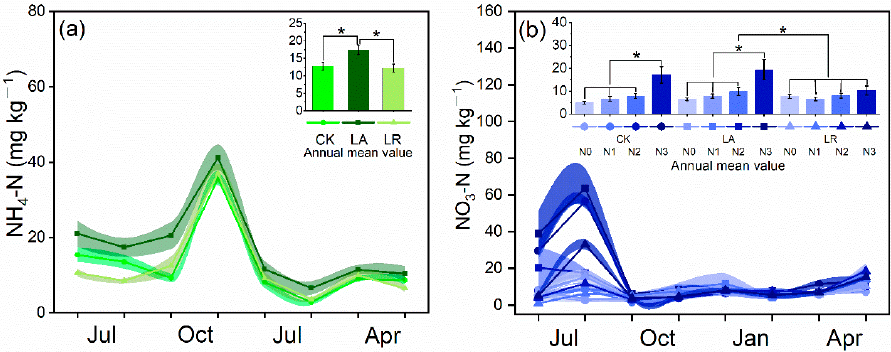
Figure 3. Seasonal variations and annual mean values of soil (NH 4 -N) ( a ) in di ff erent litter input treatments and (NO 3 -N) ( b ) in di ff erent N fertilizers and litter inputs treatments. Spline curves indicate mean ± SE ( n = 12 for NH 4 -N, n = 3 for NO 3 -N). Asterisks (*) indicate significant di ff erences (ANOVA followed by Duncan’s tests, p < 0.05).